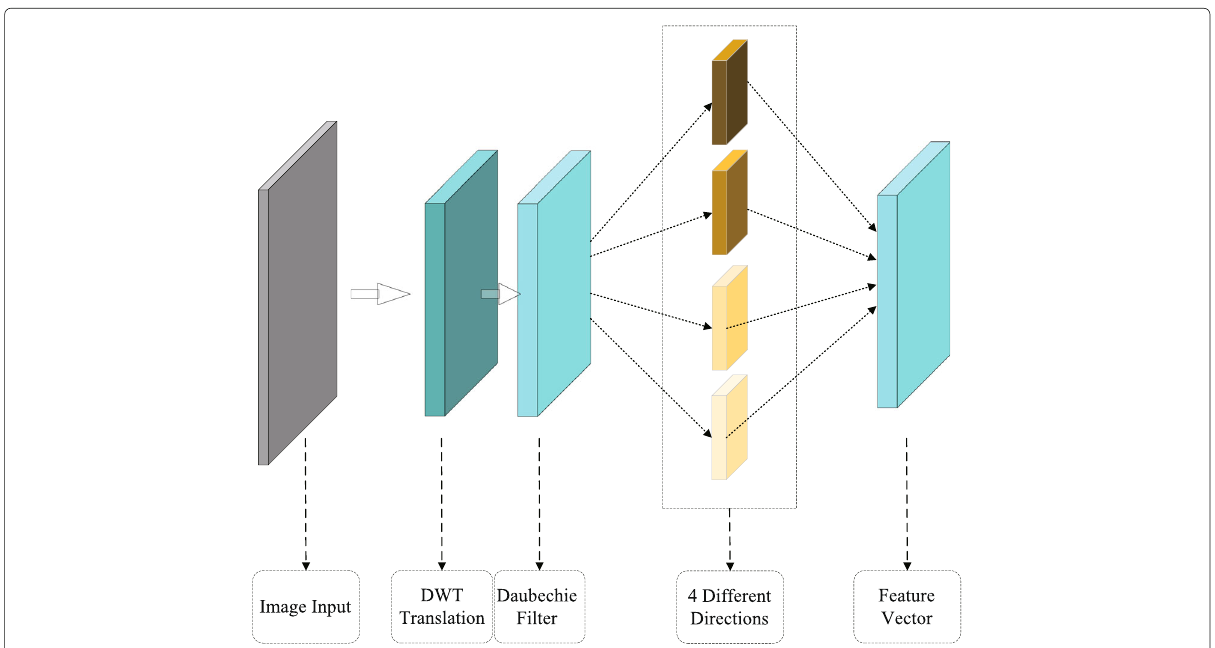
Fig. 3 Schematic of explicit feature extraction